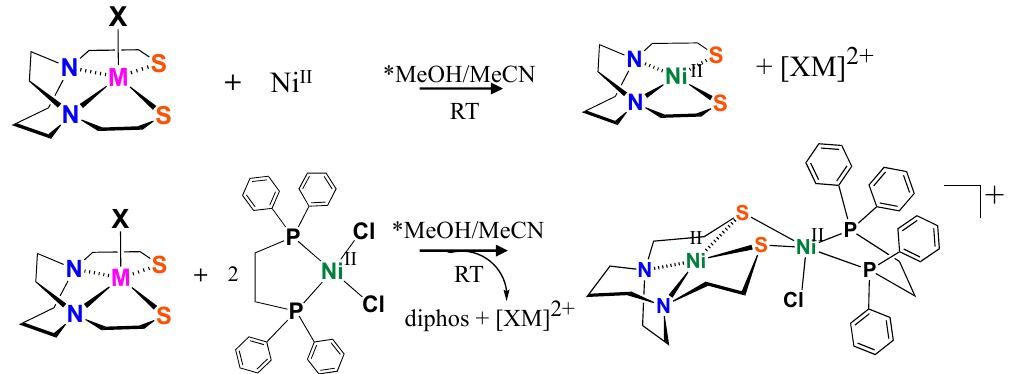
Figure 5. Reactions of XMN 2 S 2 with Ni II salts and (diphos)NiCl 2 . * Pure MeOH, or MeCN, or a mixture of MeOH/MeCN (1:1) resulted in the same products.